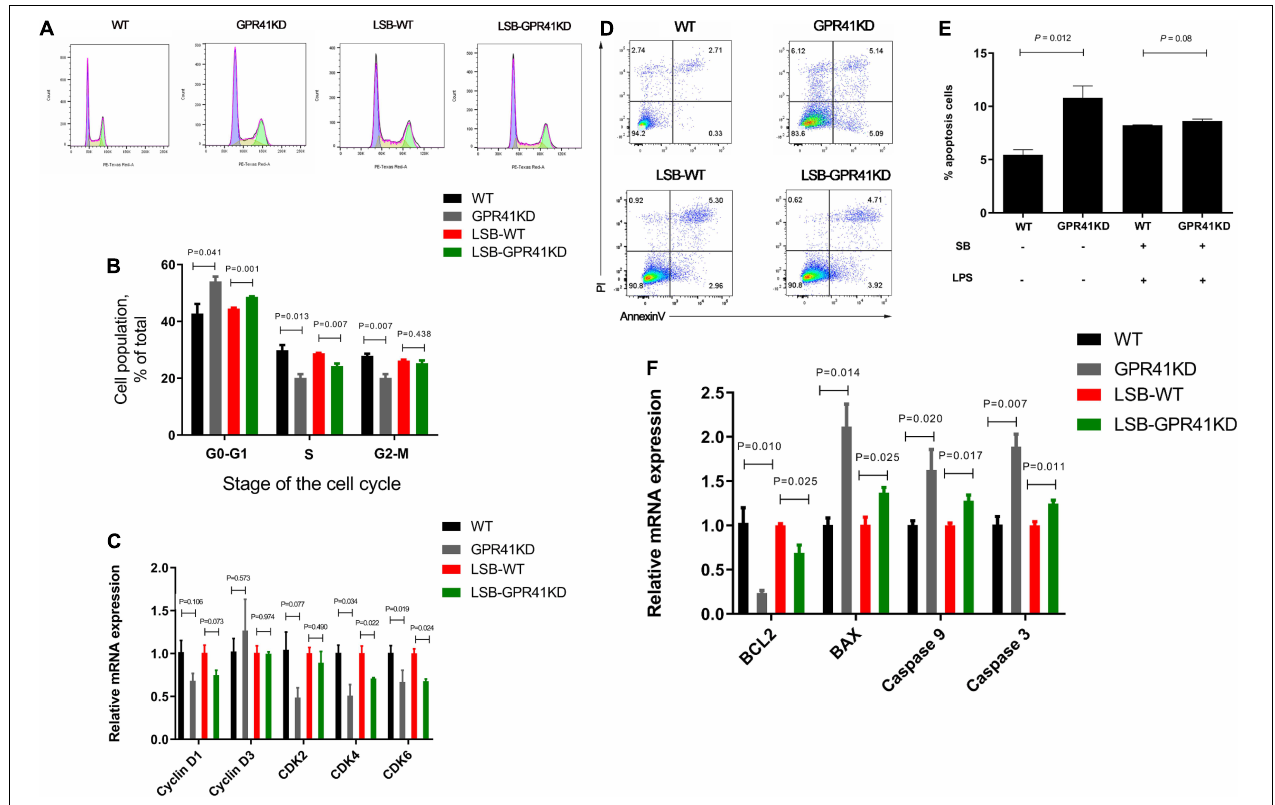
FIGURE 10 | Effect of GPR41 on proliferation and apoptosis. Generation of GPR41-knockdown (GPR41KD) BREC cell lines using the CRISPR/Cas9 system. LSB-WT, pretreatment with SB in LPS-induced BRECs; LSB-GPR41KD, pretreatment with SB in LPS-induced BRECEs-GPR41KD. After incubation, cells were analyzed by flow cytometry and qRT-PCR. (A) A representative histogram of flow cytometric analyses. (B) Percentages of cells at different phases of the cell cycle. (C) Gene expression of Cyclin D1, Cyclin D3, CDK2, CDK4, and CDK6. (D) Absorbance of FITC-A; absorbance of fluorescein isothiocyanate-Annexin V. (E) Apoptosis percentages. (F) Gene expression of Caspase 3, Caspase 9, Bcl-2, and BAX. The values are shown as mean ± SEM ( n =